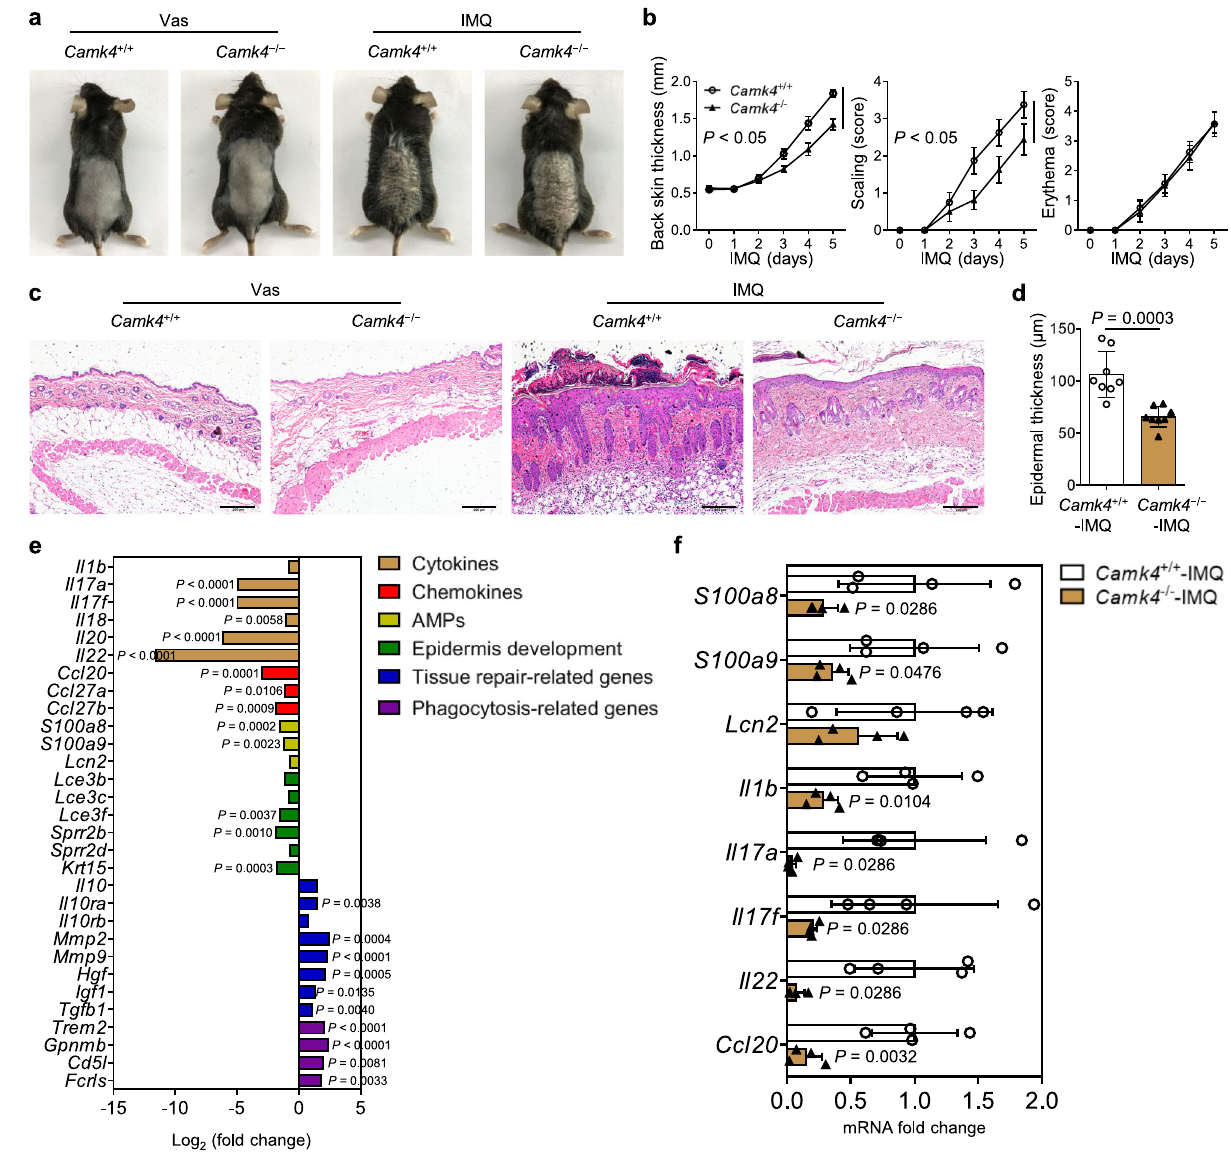
Fig. 2 | Camk4 de fi ciency alleviates the severity of IMQ-induced psoriasis. a Representative photos of mouse back skin. b Scoring curves of back skin thickness, scaling, and erythema. c H&E staining of skin sections. Scale bar= 200 μ m. d Statisticalanalysisofepidermalthickness. a – d N =7 – 8pergroupfrom two independent experiments. e RNA sequencing analysis of the whole skin showing differentially expressed genes associated with cytokines, chemokines, AMPs, epidermis development, tissue repair, and phagocytosis between IMQ-